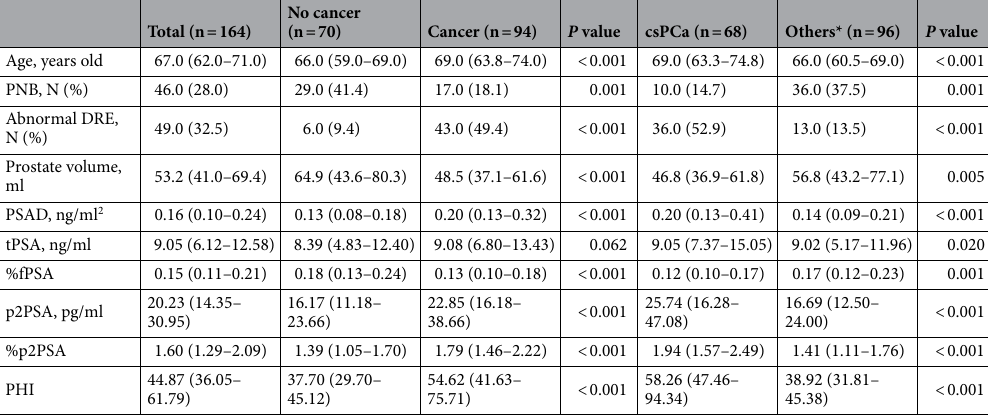
Total prostate cancer